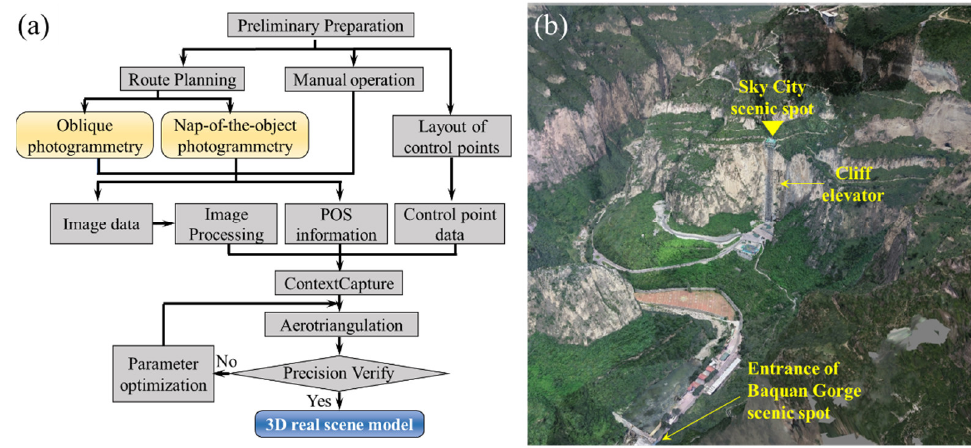
Figure 11. A 3D high-precision real scene model construction using UAV photogrammetry technol- ogy. ( a ) Construction process of 3D real scene models. ( b ) 3D real scene model of the scenic spot of Sky